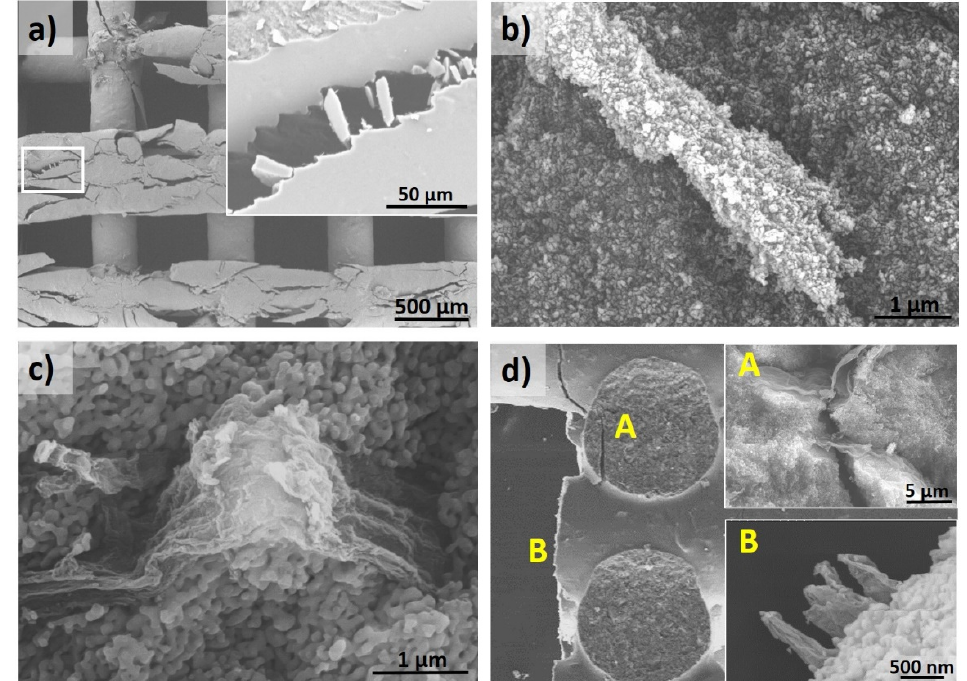
Figure 6. SEM images of fractured rGO ribbon composite structures after compression testing. ( a ) Crushed top layer of a boehmite/rGO ribbon structure showing varied damage. The inset shows a zoomed area in which pulled-out ribbons are completely covered by boehmite. ( b ) rGO ribbon protruding from the rod fracture surface in a γ -Al 2 O 3 /rGO ribbon structure. The γ-Al 2 O 3 grains decorate the whole ribbon surface. ( c ) Rod fracture surface in an α -Al 2 O 3 /rGO ribbon structure. Ribbon morphology constituted by the graphene layers of an open nanotube is clearly appreciated. ( d ) Side view of a fractured α -Al 2 O 3 /rGO ribbon structure, showing examples of a bridged crack crossing structure node (A) and typical ribbon pull-out length observed at the edge (B).